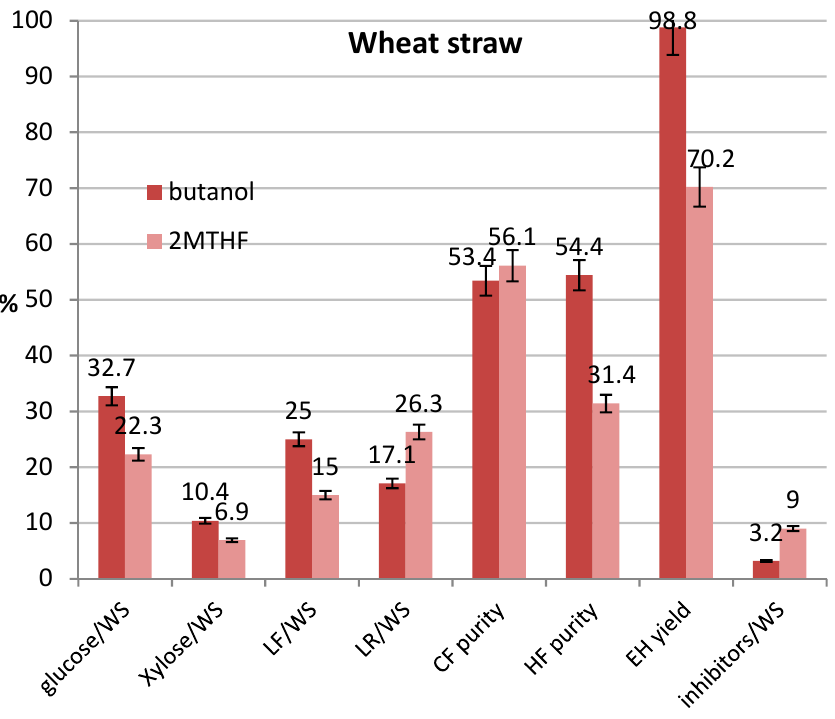
Figure 8. Fractionation and hydrolysis of WS by pretreatment with butanol and 2M-THF.